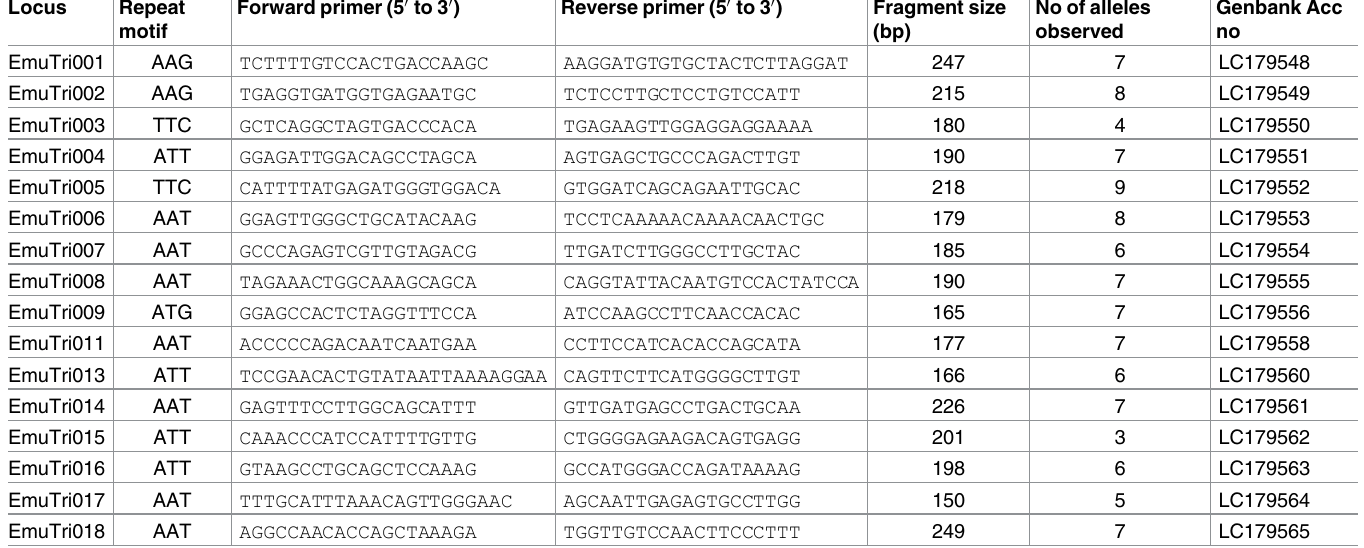
Table 2. Characterization of 18 microsatellite DNA loci designed for Eunectes murinus .